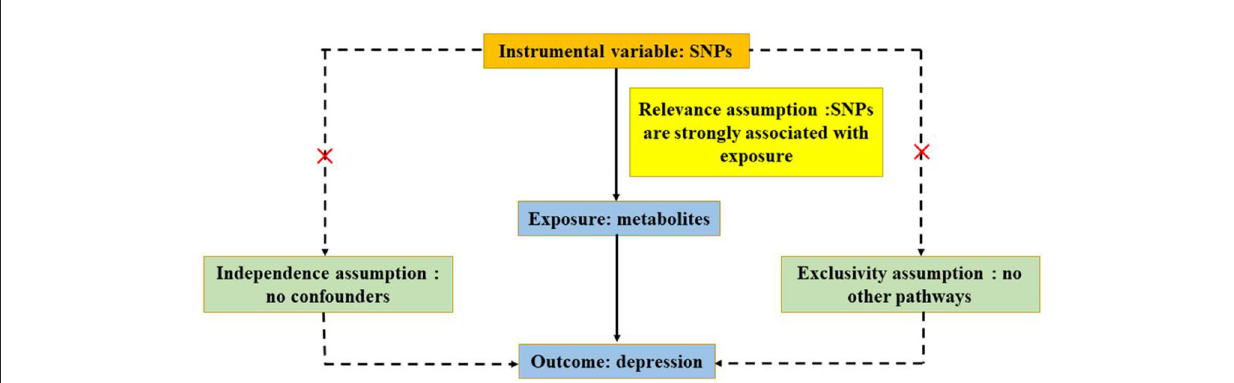
FIGURE1 Three significant assumptions of metabolites on depression via forward MR. The three paths represent these three different assumptions. Relevance assumption: SNPs are associated with metabolites (the exposure). Independence assumption: SNPs are completely independent of any potential confounding factors that influence metabolites and depression. Exclusivity assumption: SNPs affect metabolites only through metabolites (exposure) and not via any alternative causal pathways.